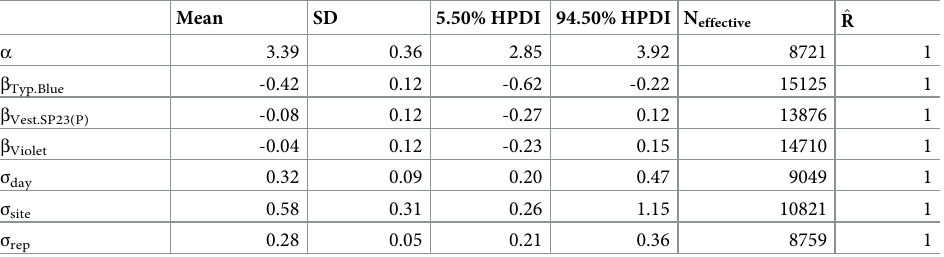
SD = standard deviation; HPDI = highest posterior density interval; N effective (= the effective number of samples) and ^ R are convergence and efficiency diagnostics for Markov chains used in model